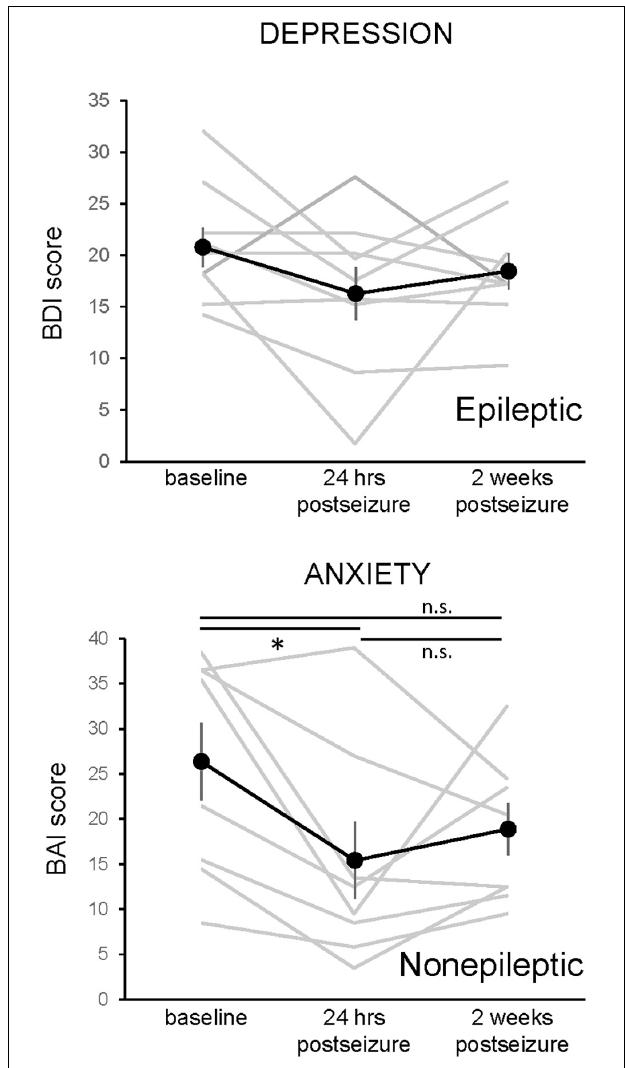
FIGURE 5 | Changes in depression and anxiety symptoms 24-h and 2 weeks following an epileptic or non-epileptic seizure. Depression symptoms, as assessed with the Becks Depression Index-II (BDI, upper graph, n = 9), and anxiety symptoms, as assessed with the Beck Anxiety Inventories (BAI, lower graph, n = 8), are shown at baseline, in the 24 h following an epileptic (BDI) or non-epileptic (BAI) seizure, and 2 weeks after the last seizure. The effects of epileptic seizure on the BDI score were not statistically significant (rmANOVA). There was a main effect of non-epileptic seizures in the BAI (rmANOVA, F ( 1 . 97 , 13 . 42 ) = 4.657, p = 0.0303). Paired post-hoc comparisons revealed that the 24-h postseizure time point was significantly lower than the baseline value and that the 2-week time point was not different from either baseline or 24 h postseizure. Data presented as mean ± SEM, with responses of individual patients shown in